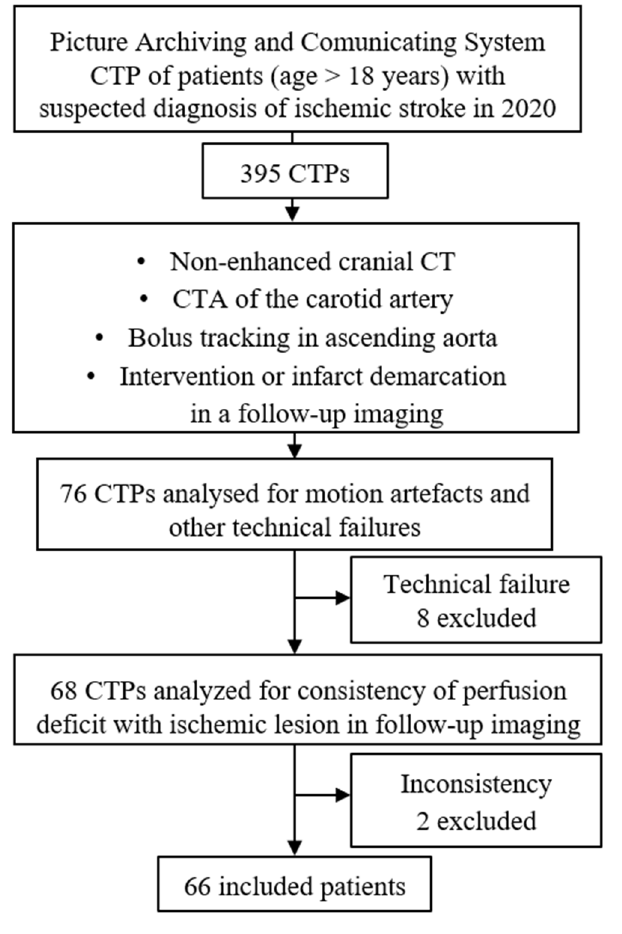
Figure 1. Flow chart of patient recruitment.